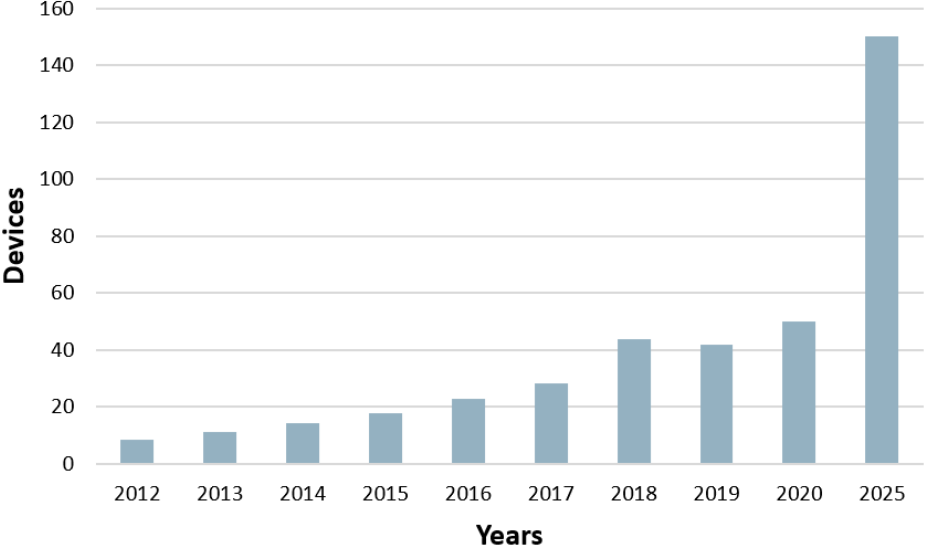
Figure 1. Growth in IoT devices .